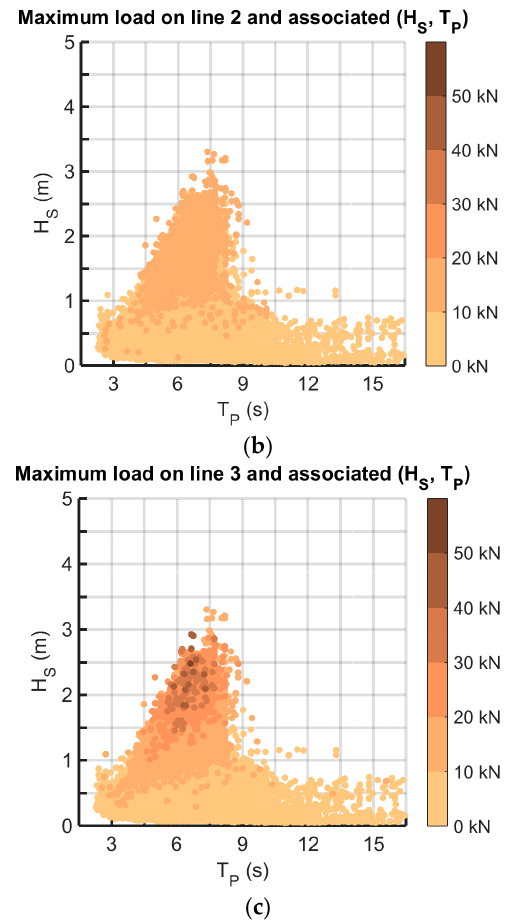
Figure 9. Summary of the measured maximum mooring loads at SWTMF and of the associated environmental conditions for ( a – c ) lines 1–3.